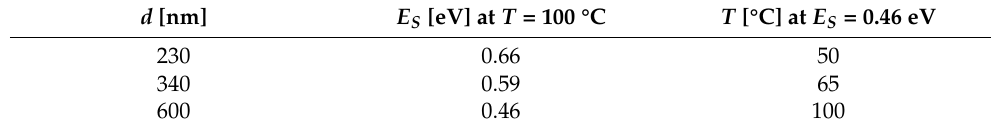
Table 2. A comparison between experimental droplet morphologies and the simulation results obtained using this approach are shown in Figure